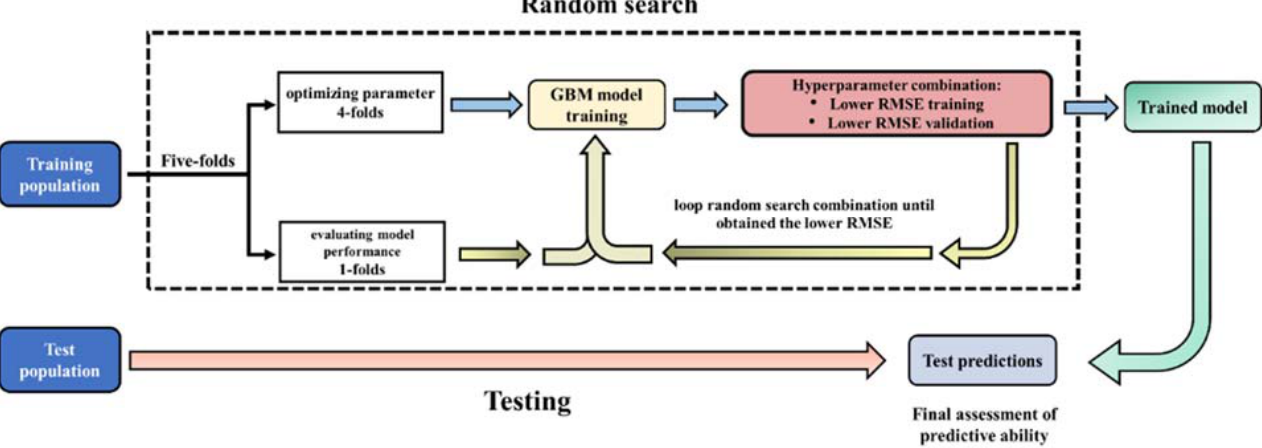
Figure 2. An illustration of a random search of hyperparameter optimization for a gradient boosting machine (GBM). The general process includes splitting the training population from each validation scenario (10-fold_HO, BS_HO, BS+HO_10-fold, Multi-breed, and Multi-breed CV2) into 5 folds, aiming to optimize the main parameters of the GBM approach to accurately learn the mapping from the milk spectra data to the target trait, i.e., lowest root mean square error estimation (RMSE). Thus, the trained model is then evaluated on the disjointed test population from each cross-validation scenario.